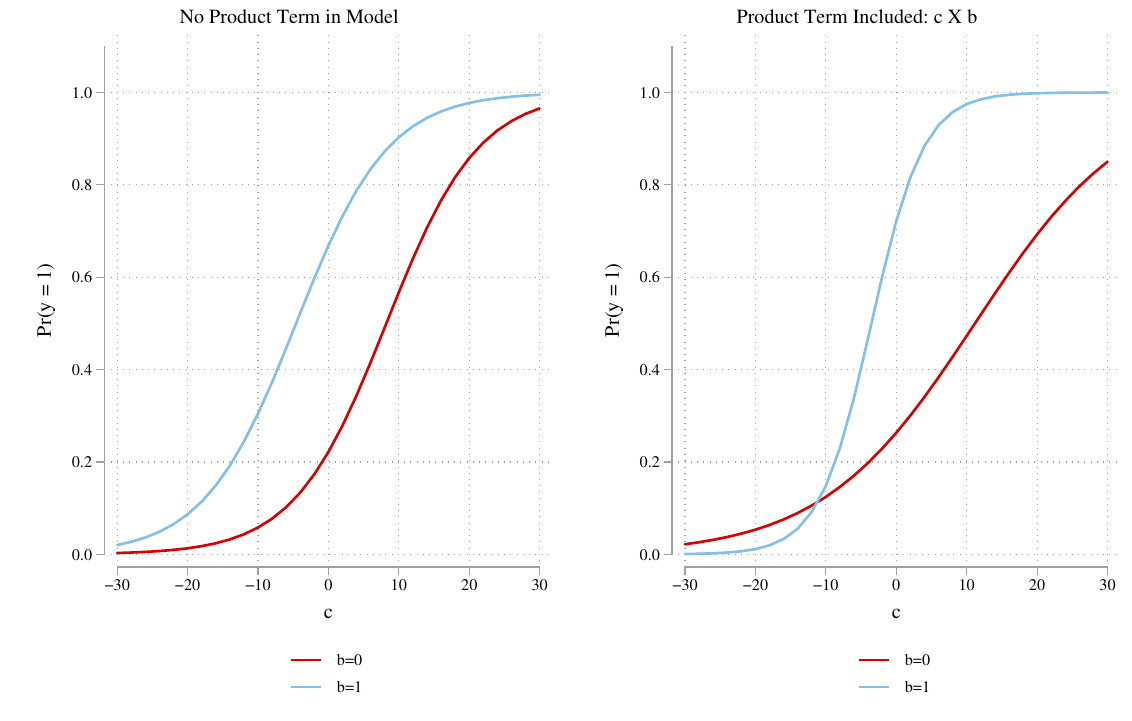
Figure 8: Effect of excluding a needed product term: the true coefficient on the product term is not